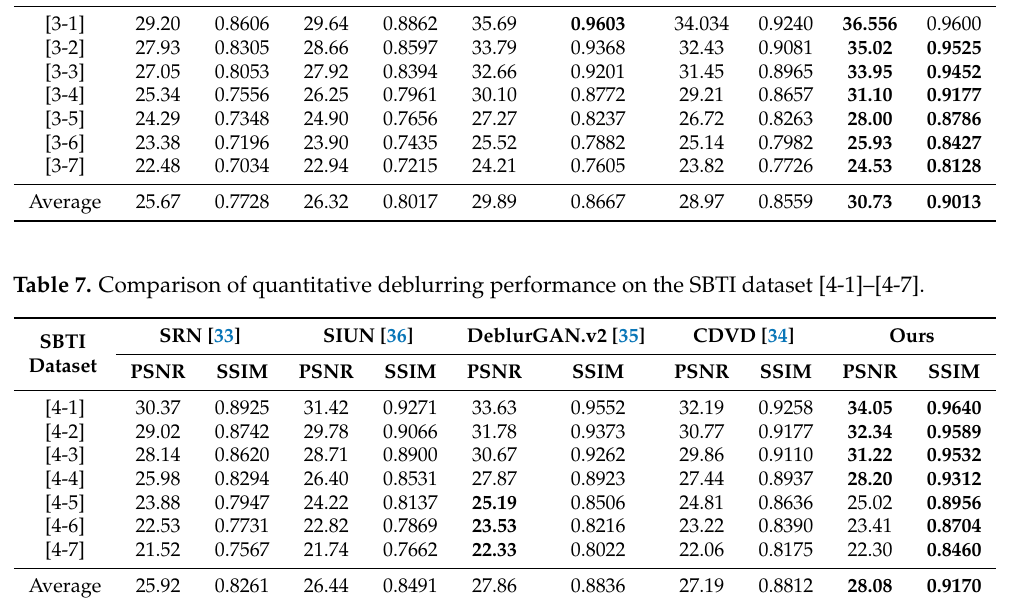
Table 6. Comparison of quantitative deblurring performance on the SBTI dataset [3-1]–[3-7]. SBTI Dataset